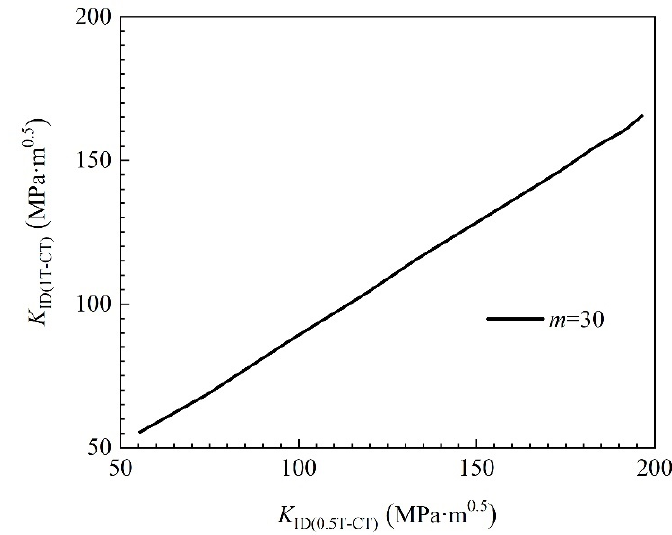
Figure 15. Fracture toughness conversion curves of 1T-CT and 0.5T-CT samples.